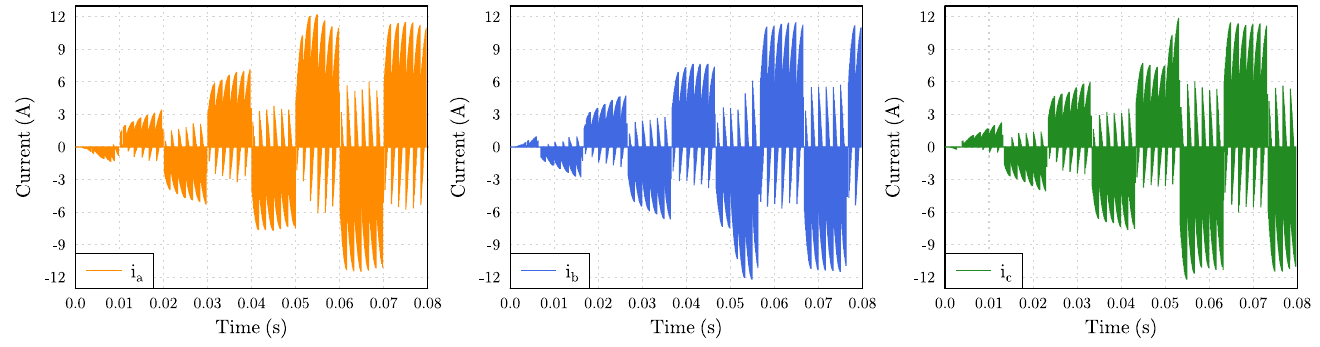
Figure 15. Input currents of the DMC controlled by SVM.